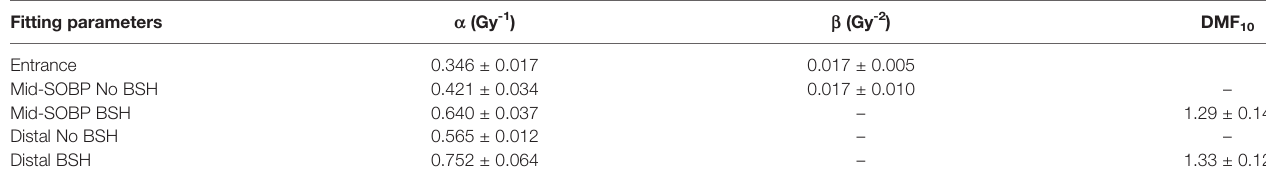
TABLE 1 | Linear-quadratic fi tting parameters and DMF 10 for survival curves obtained after irradiation of DU145 along the CNAO proton beam SOBP. Fitting